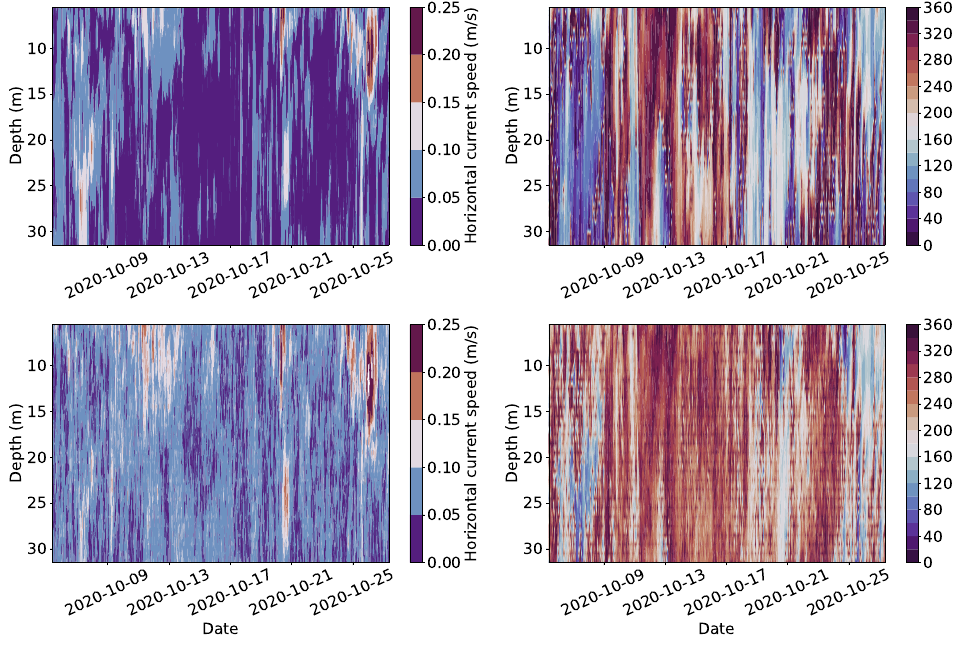
Figure 3. Horizontal speed ( left ) and current direction ( right ) measured by the SailBuoy ADCP ( top ) and the bottom-mounted ADCP ( bottom ), respectively, over time in Fusafjorden, October, 2020.